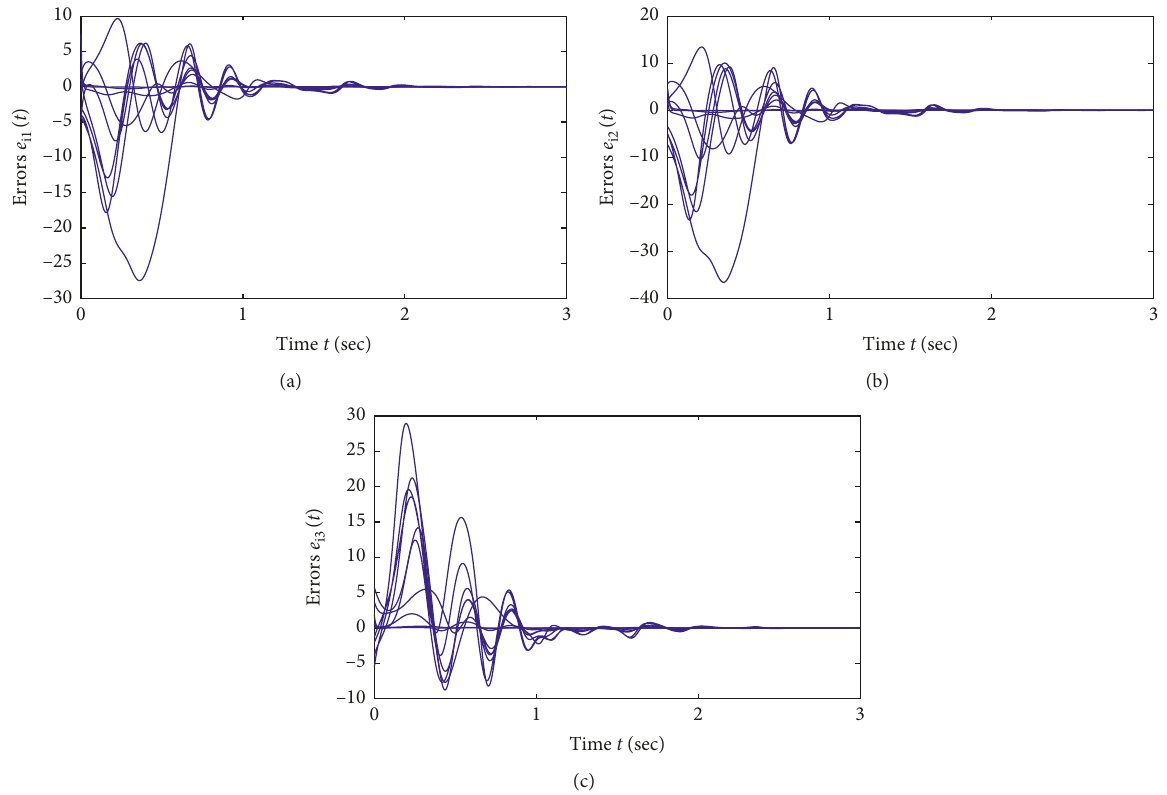
,e e i 1 i 2 , and i 3 with λ 1